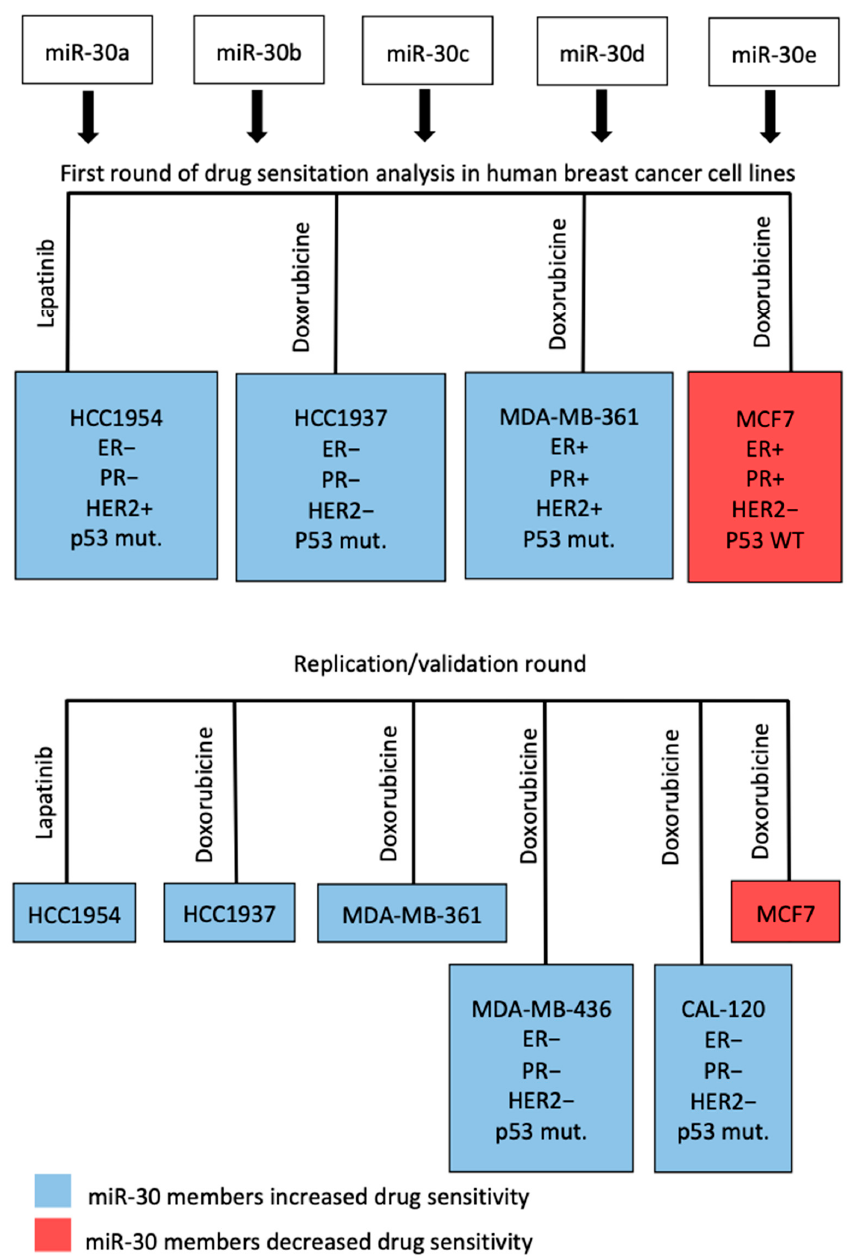
Figure 3. Diagram of the workflow of the drug-screening. The HER2-positive HCC1954 cell line was strongly sensitized to HER2-targeting lapatinib when transfected with miR-30 family member mimics, compared to the inhibitors (largest p = 0.001) (Figure 4a, Table S4). The association was reproduced in the replication round with the largest p = 0.012. Table S4 and Figure S3A illustrate the comparison of